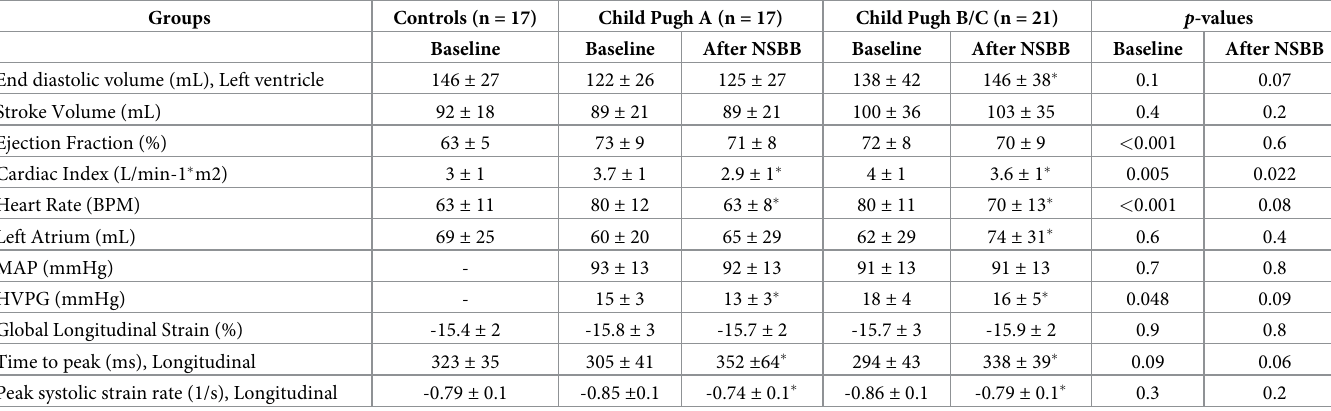
p -values for parametric data were calculated with ANOVA test, and with the Kruskal-Wallis test for non-parametric data. Data are presented as mean ± SD. Paired